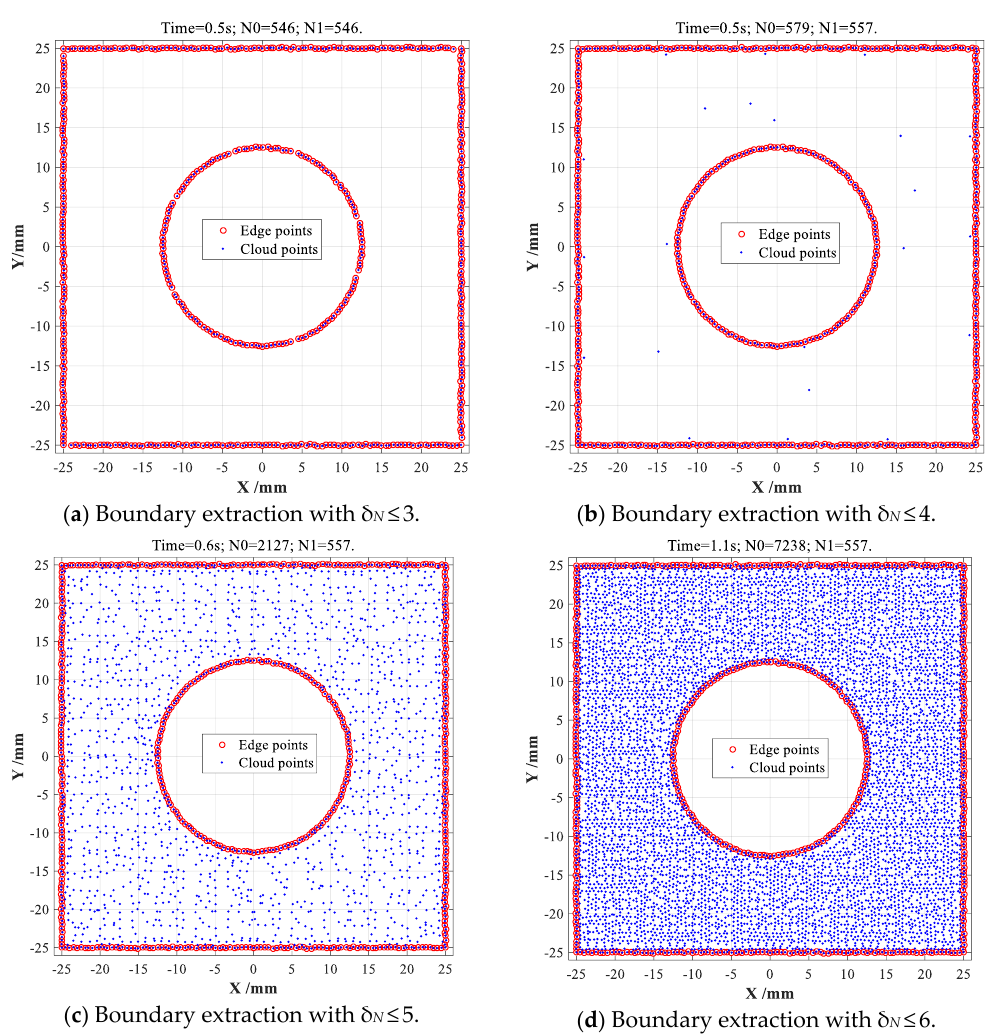
Figure 8. Statistical CDTM-based boundary extraction on SC-shaped point cloud with different δ N .